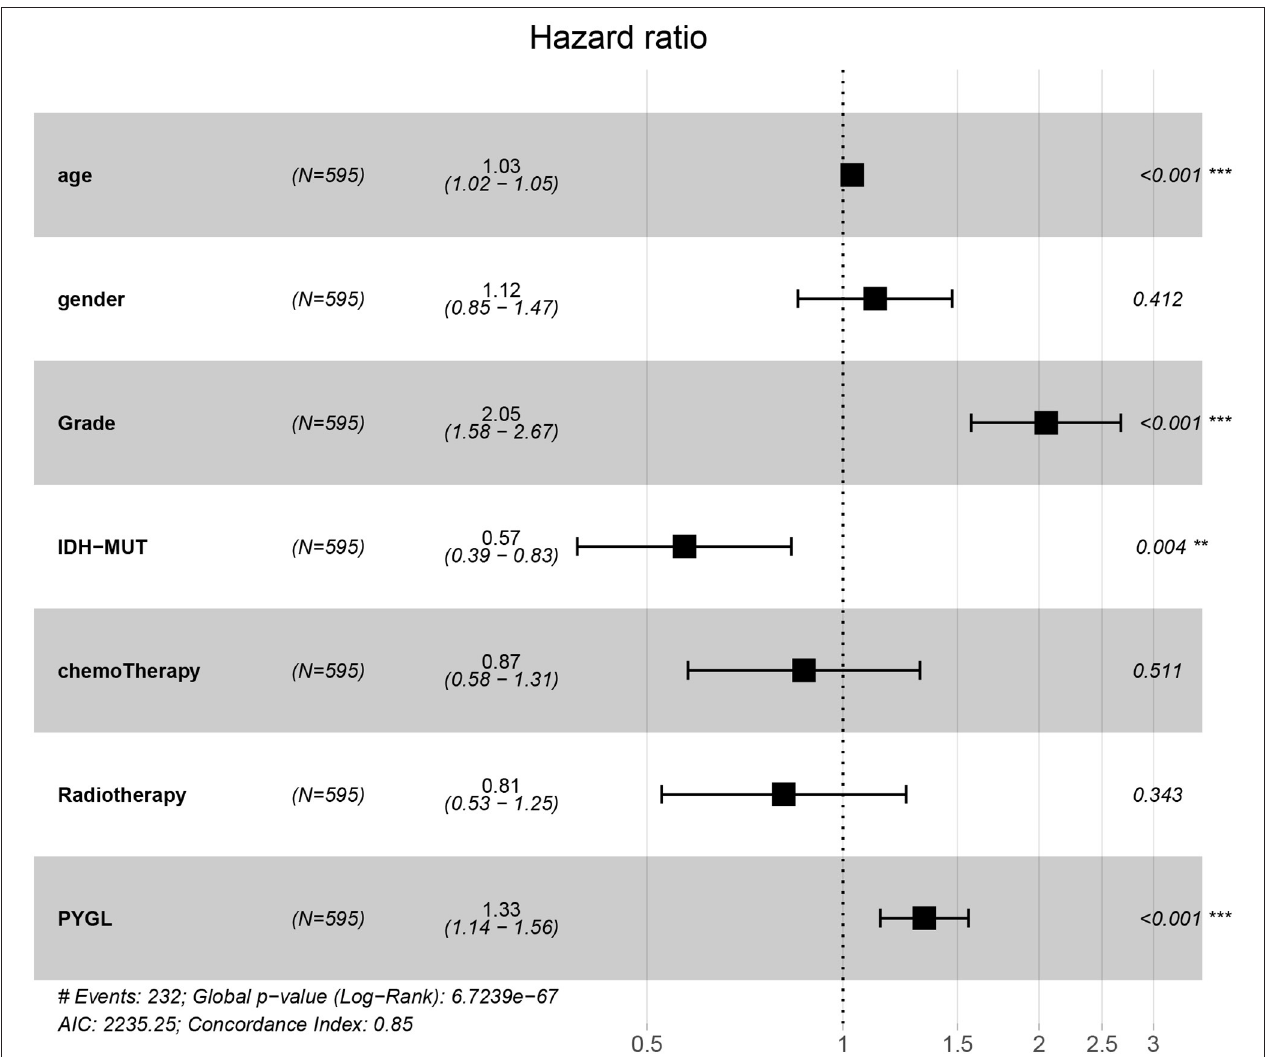
FIGURE 3 | Multivariate Cox hazards regression analyses of age, gender, grade, chemotherapy, radiotherapy and PYGL. (** P < 0.005, *** P < 0.001).